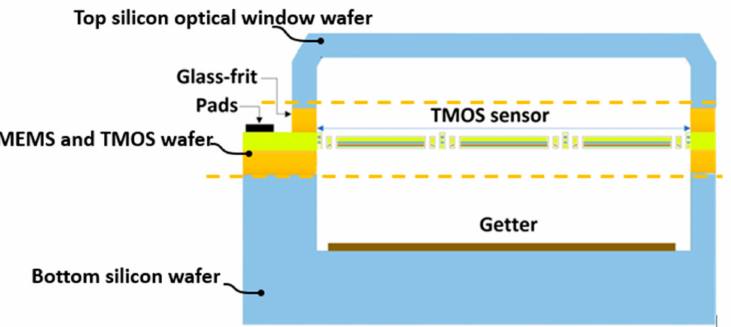
Figure 2. Schematic of the wafer-level package architecture with a getter layer for a high